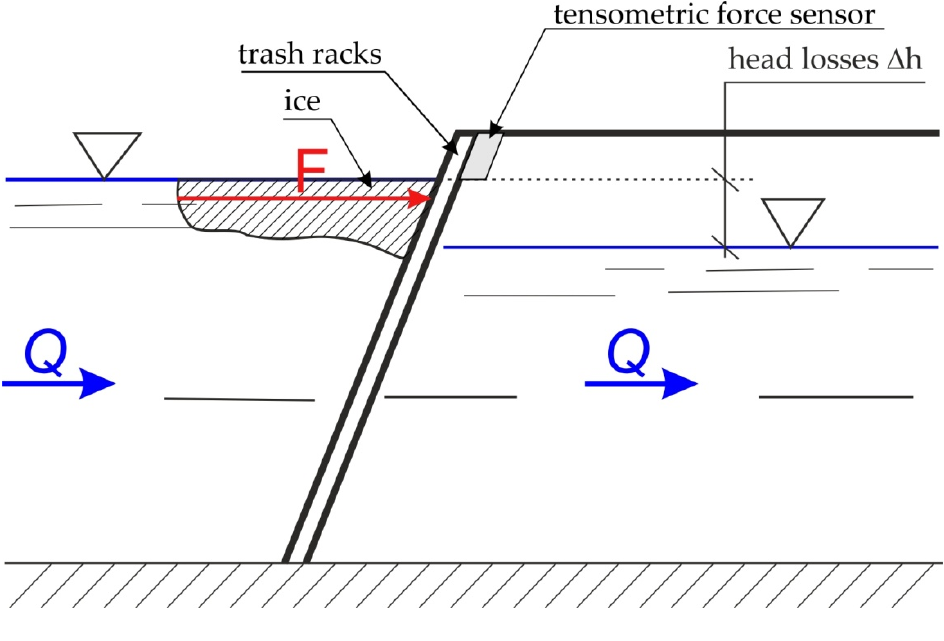
Figure 2. Dynamometric platform.